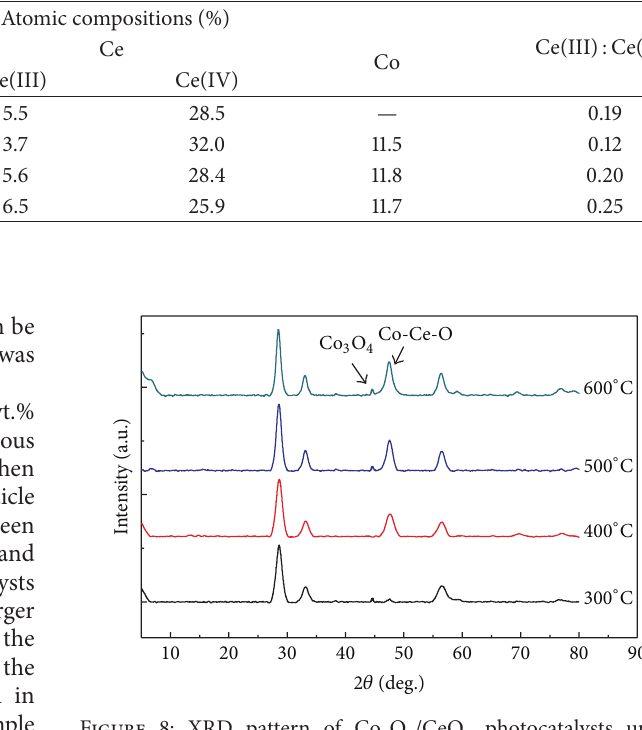
Table 4: Atomic compositions (%) measured from the O 1s, Ce 3d, and Co 3s spectra of CeO calcination temperatures.